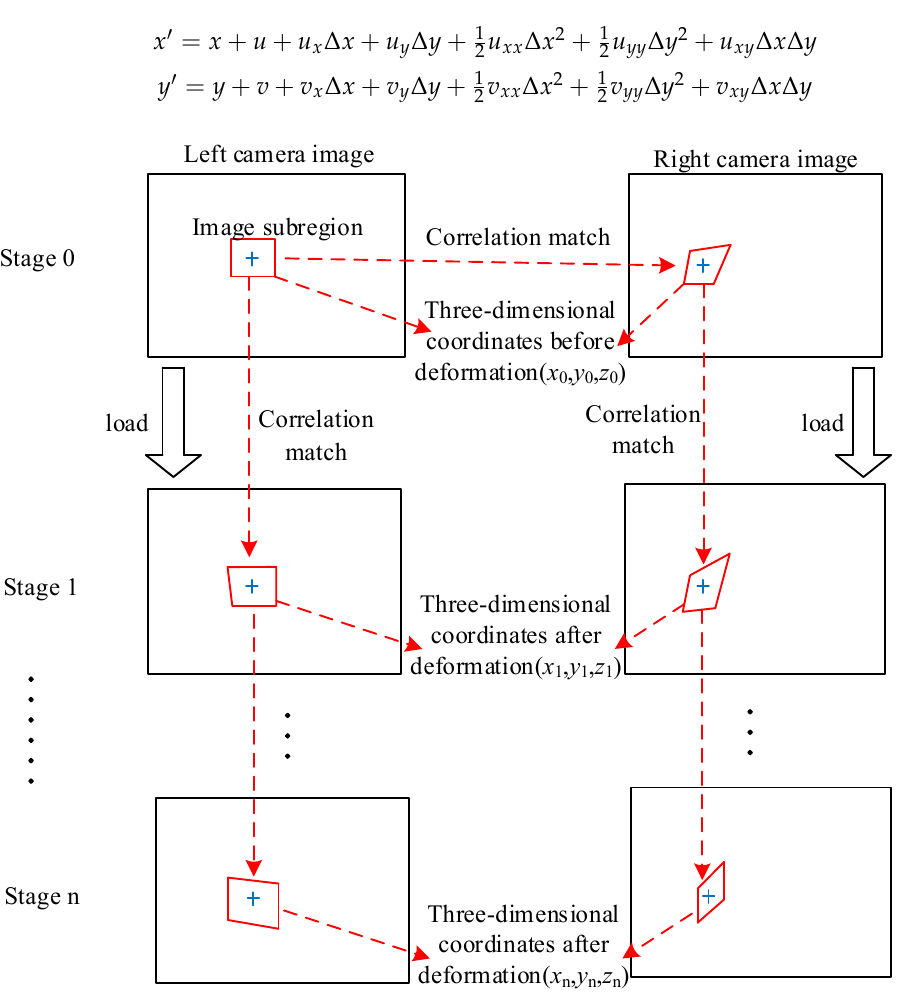
Figure 2. Calculation steps of 3D displacement.